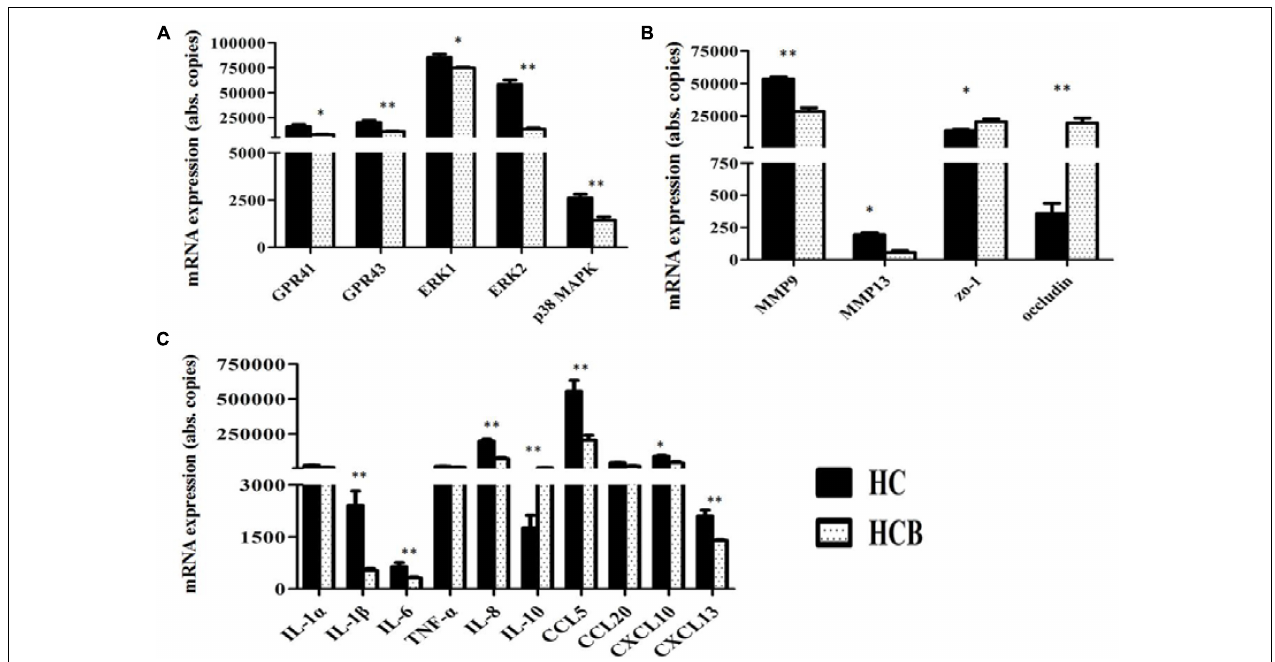
FIGURE 3 | Effect of sodium butyrate on the expression of candidate genes in the cecal mucosal tissue of lactating goats. The levels of candidate gene expression are indicated on the ordinate axis (mean ± SEM). (A) Expression levels of GPR41/43 and transcription factors, (B) MMPs and TJPs, (C) and inflammatory cytokines and chemokines. Significant differences between HC and HCB groups are represented by ∗ P < 0.050 or ∗∗ P < 0.010.